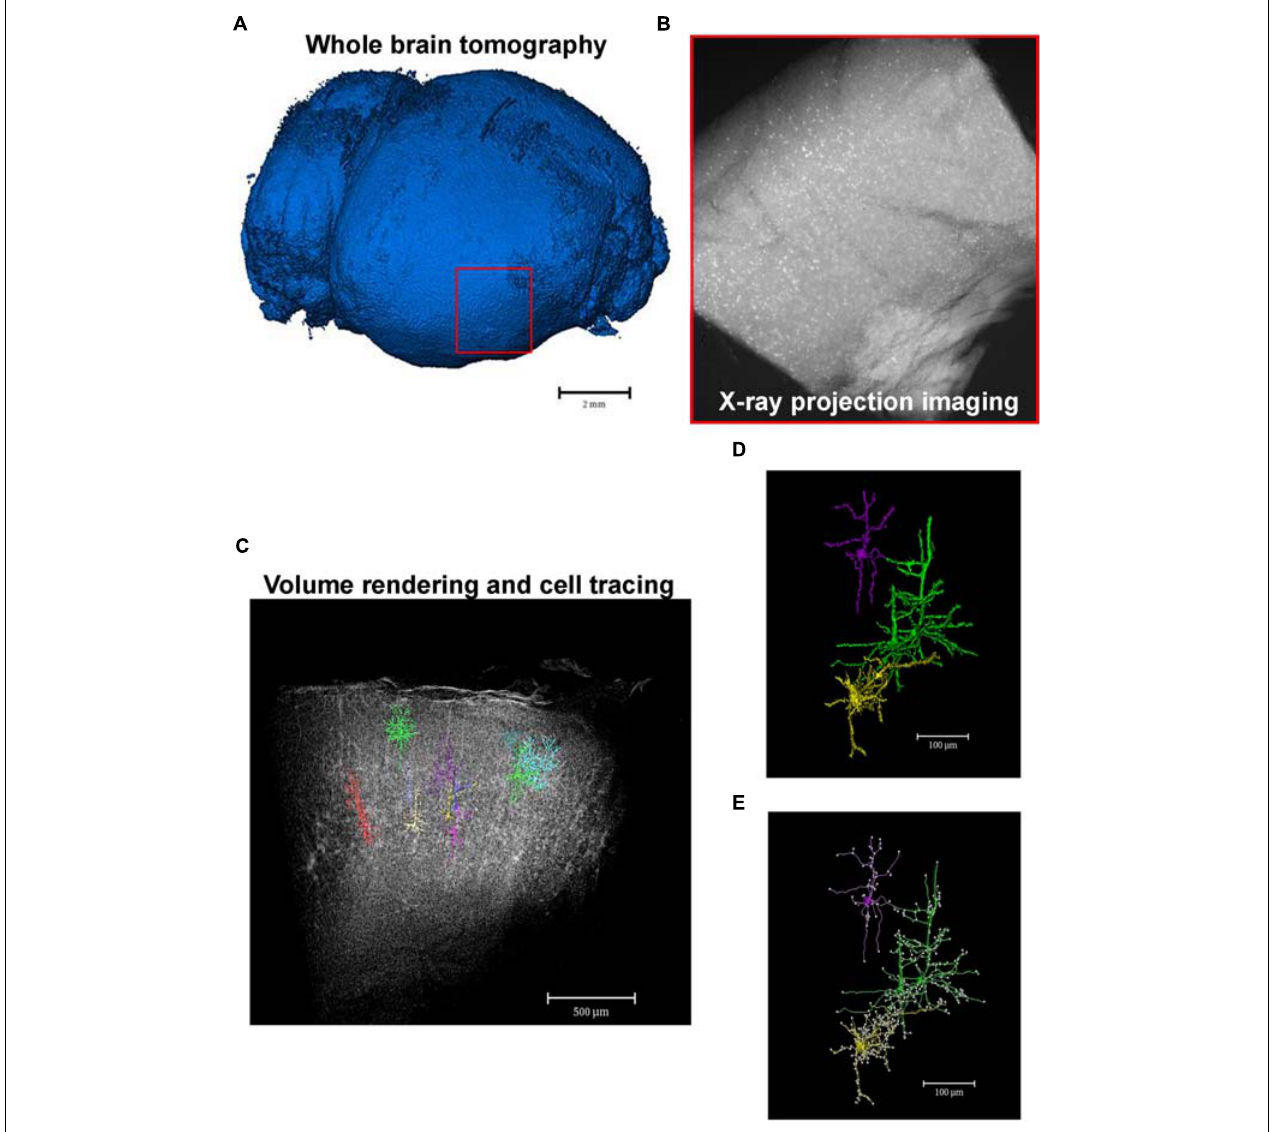
FIGURE 3 | From macro- to microscale imaging in the same set of image acquisition. X-ray µ CT allows for the acquisition of images from whole intact organs which can then be virtually sliced and analyzed in a microscale. (A) Whole tomography of a paraffin-embedded mouse brain. Red square shows the region of interest to be analyzed in a high-resolution microscale. (B) X-ray absorption projection of Golgi-Cox-labeled brain region selected in panel (A) . Bright spots represent successfully mercury-impregnated neurons. (C) Volume rendering of the whole region selected in panel (A) showing some segmented neurons within the structure. (D) Cellular segmented neurons of the structure represented in panel (C) . Colors highlight a single neuron or a cluster of cells that could not be separated due to close proximity. (E) Example of analyzes of neuronal branching patterns. Each white dot represents a cell